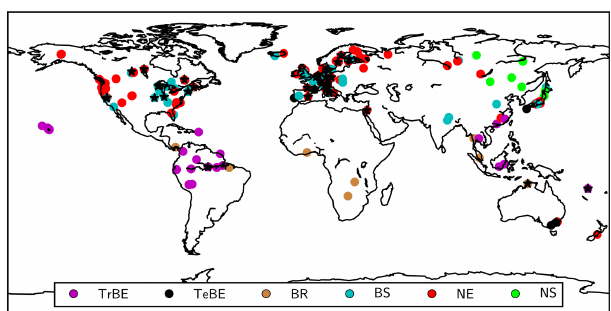
Figure 2. Locations of the sites used for model evaluation. Black stars: FLUXNET sites; circles: GFDB sites with circles having colours corresponding to different PFTs (see Table